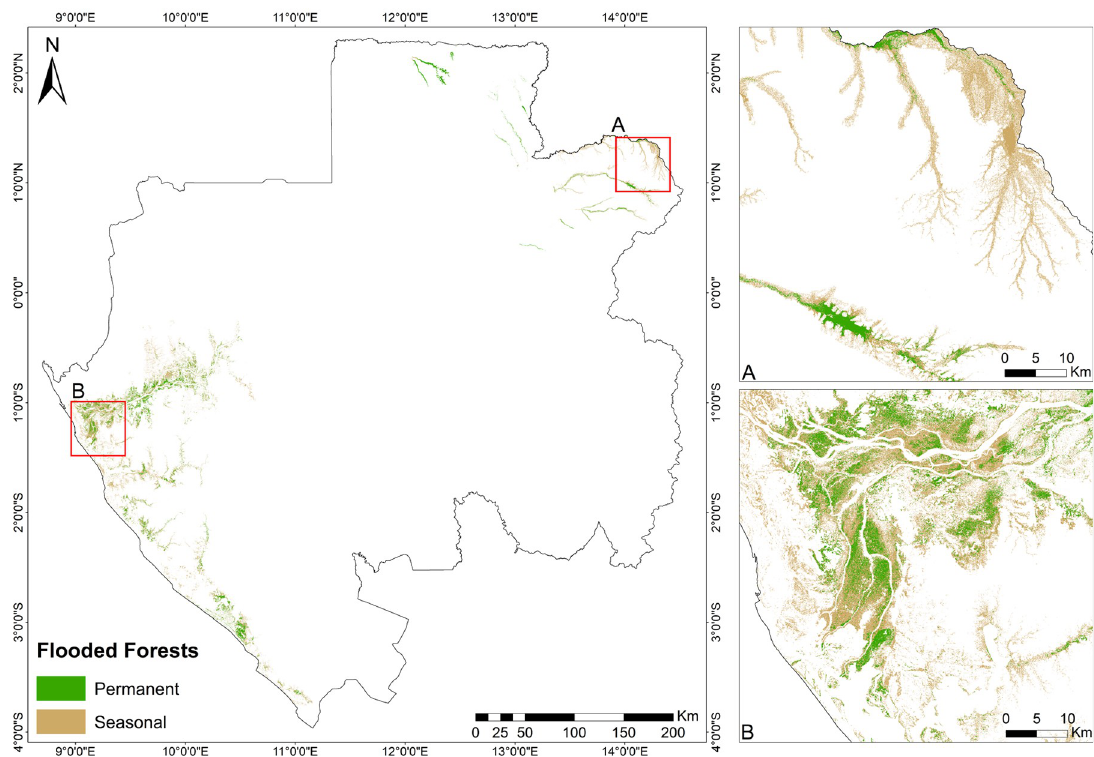
Fig 9. Seasonally and permanent flooded forests in Gabon derived from ALOS PALSAR’s L-band SAR imagery. (A) and (B) show details of flooded forests in the Middle Ogooue and Ogooue-Ivindo provinces,